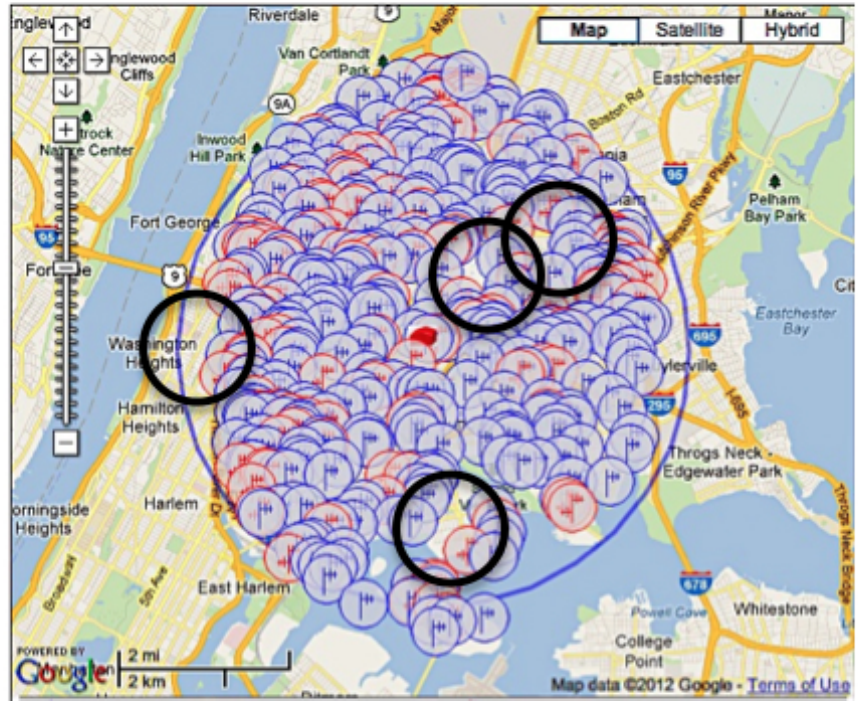
Figure 7. Antenna sites: Bronx Borough, New York. Black circles indicate gaps in service.